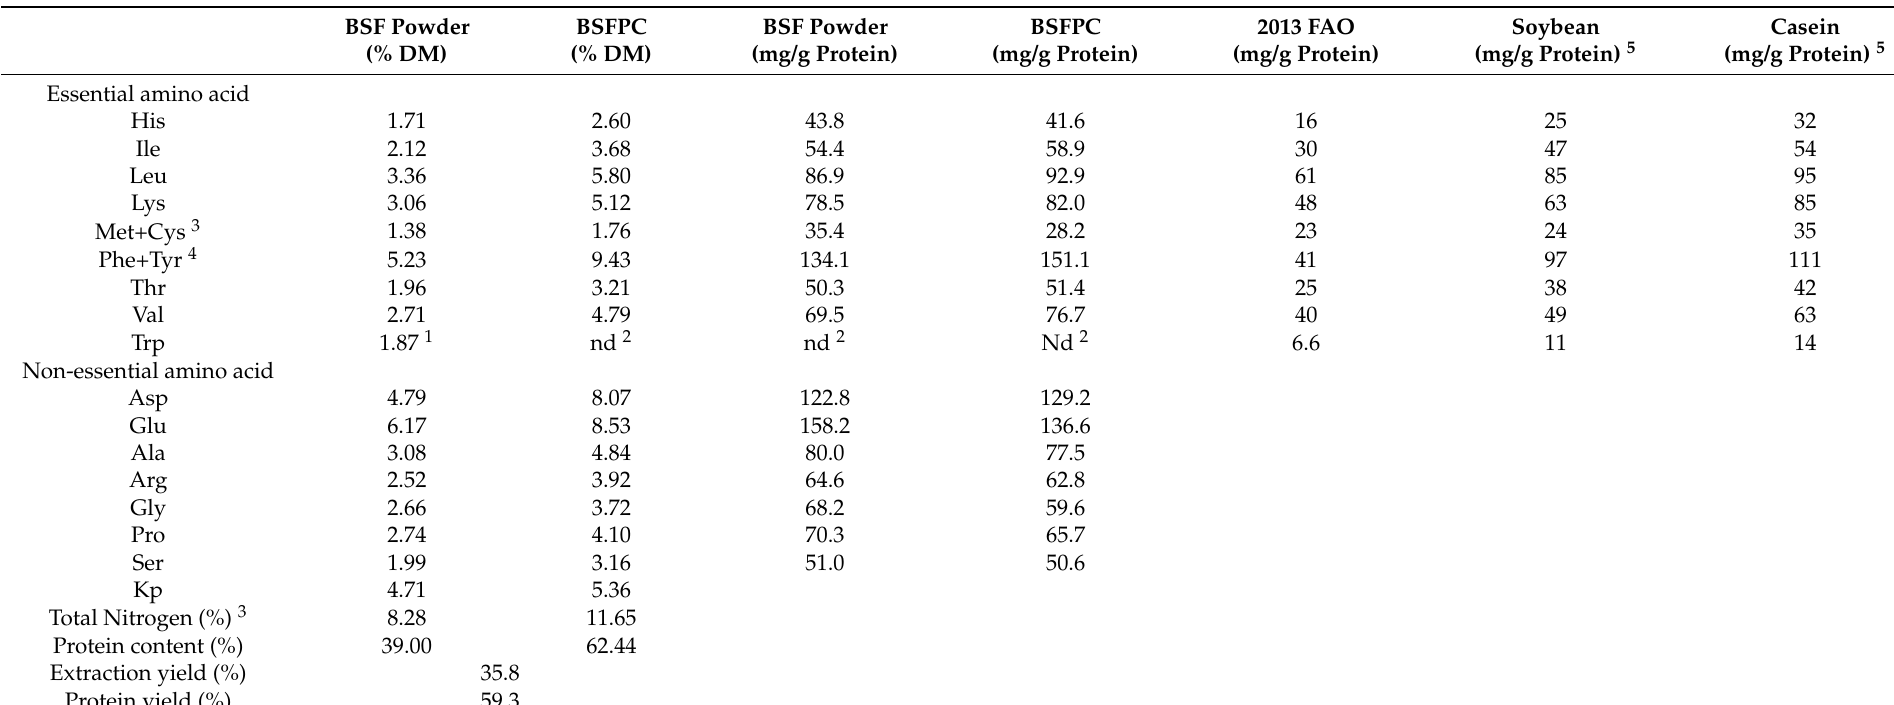
Table 2. Amino acid composition, total nitrogen, and calculated Kp (nitrogen to protein conversion factor) value and protein content for BSF (black soldier fly) powder and BSFPC (black soldier fly protein concentrate), compared to soybean, casein, and FAO (Food and Agriculture Organization) recommendation for